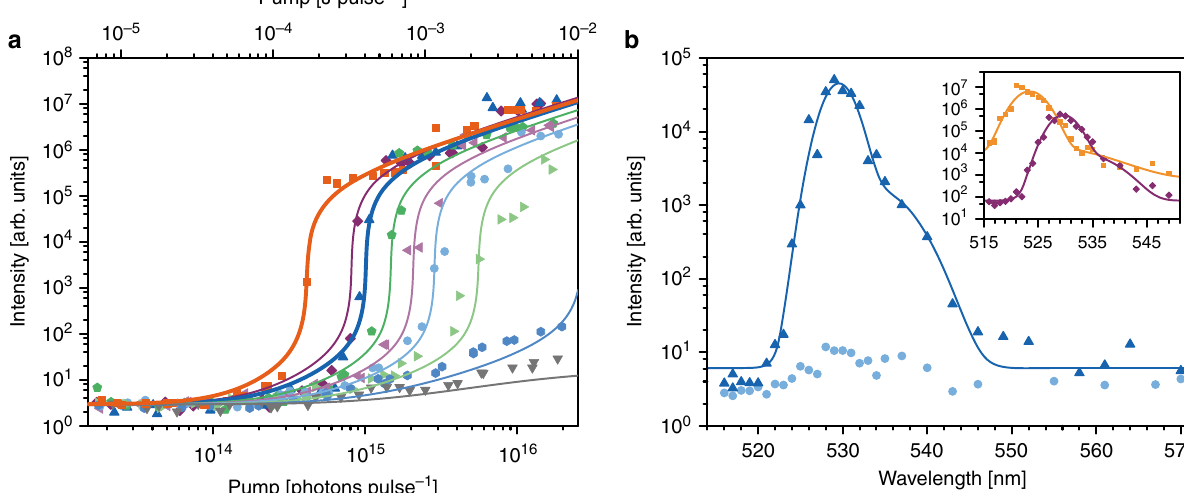
Fig. 2 Virus lasers. a Threshold behaviour in R1 for 146 nmol mL − 1 fl uorescein (F1, dark orange) and for virus-lasing probes (V1) diluted from 413 pmolmL − 1 (purple) to 351 pmolmL − 1 (dark blue, equivalent to 135 nmol mL − 1 fl uorescein), 270 pmolmL − 1 (green), 219 pmol mL − 1 (light purple), 185 pmol mL − 1 (cyan), 140 pmol mL − 1 (light green), 103 pmolmL − 1 (blue), and 72 pmolmL − 1 (grey). The fi tted curves represent a global fi t of all of the sets of threshold data to a theoretical model (Supplementary Fig. 5; Methods). Errors in the concentration described in Methods. b Emission spectra of V1 at 413 pmolmL − 1 spectrum of V1 (purple, pumping of 1.5 × 10 15 photons pulse − 1 ± 10.9%) relative to 72 nmolmL − 1 fl uorescein (orange, 1.7 × 10 16 photons pulse − 1 ±